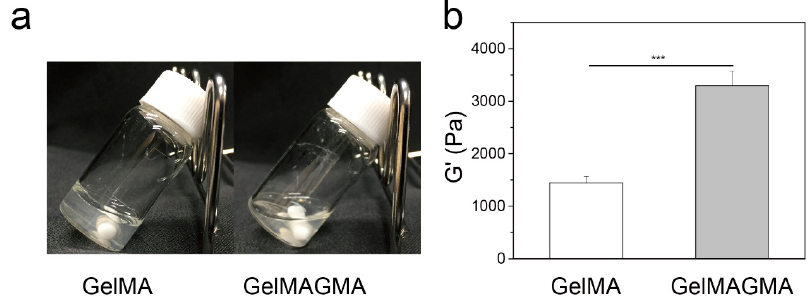
Figure 2. Gross appearance of GelMA and GelMAGMA solution (10%, w / v ) at room temperature ( a ). The storage modulus ( G ’) of GelMA and GelMAGMA hydrogels at 37 °C with a constant deformation of 5% and a frequency of 1 Hz ( b ). The data represent means ± SD, N = 3. *** p < 0.005.